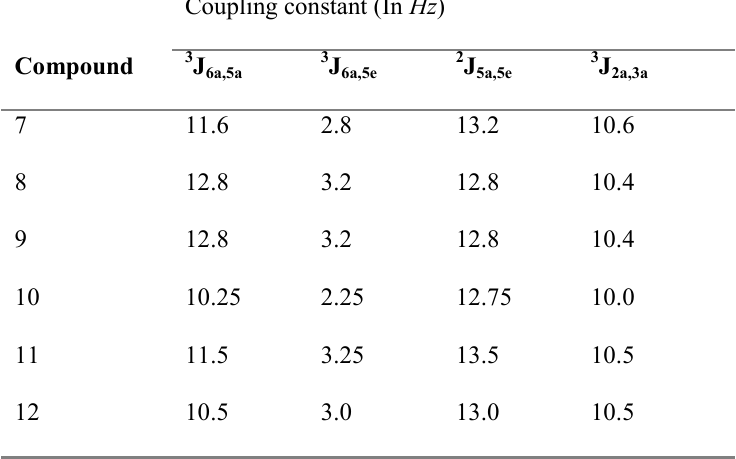
Table 1. Coupling constant of Compounds 7 – 12 .